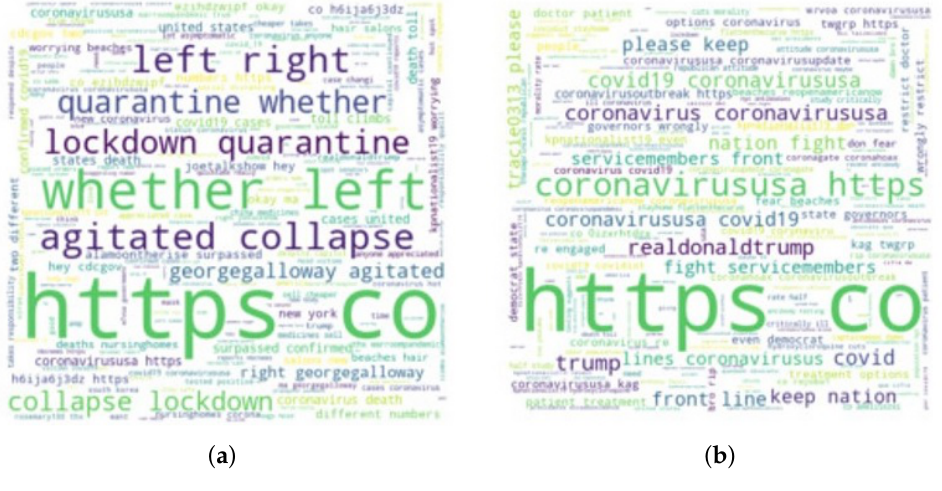
Figure 4. Word cloud of ( a ) positive tweets and ( b ) negative